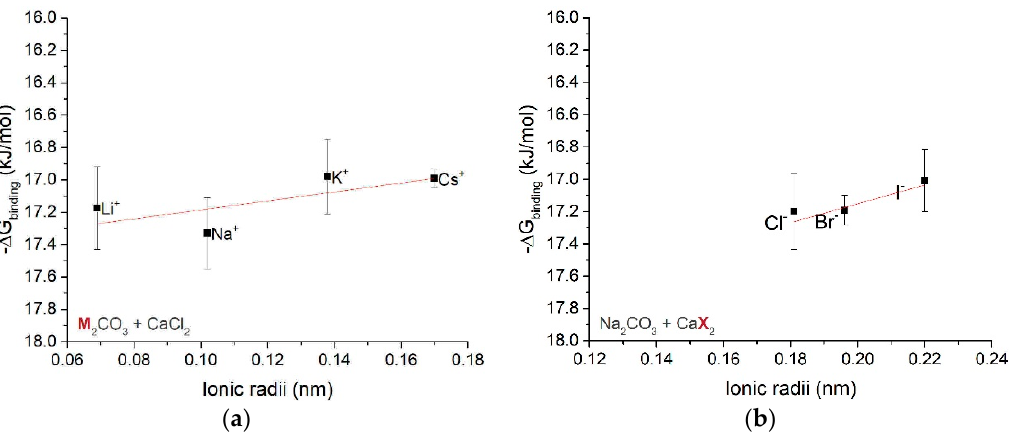
Figure 3. Δ G binding calculated for ( a ) different cations in the carbonate source, and ( b ) different anions in the calcium source. Errors bars show 2 σ N .